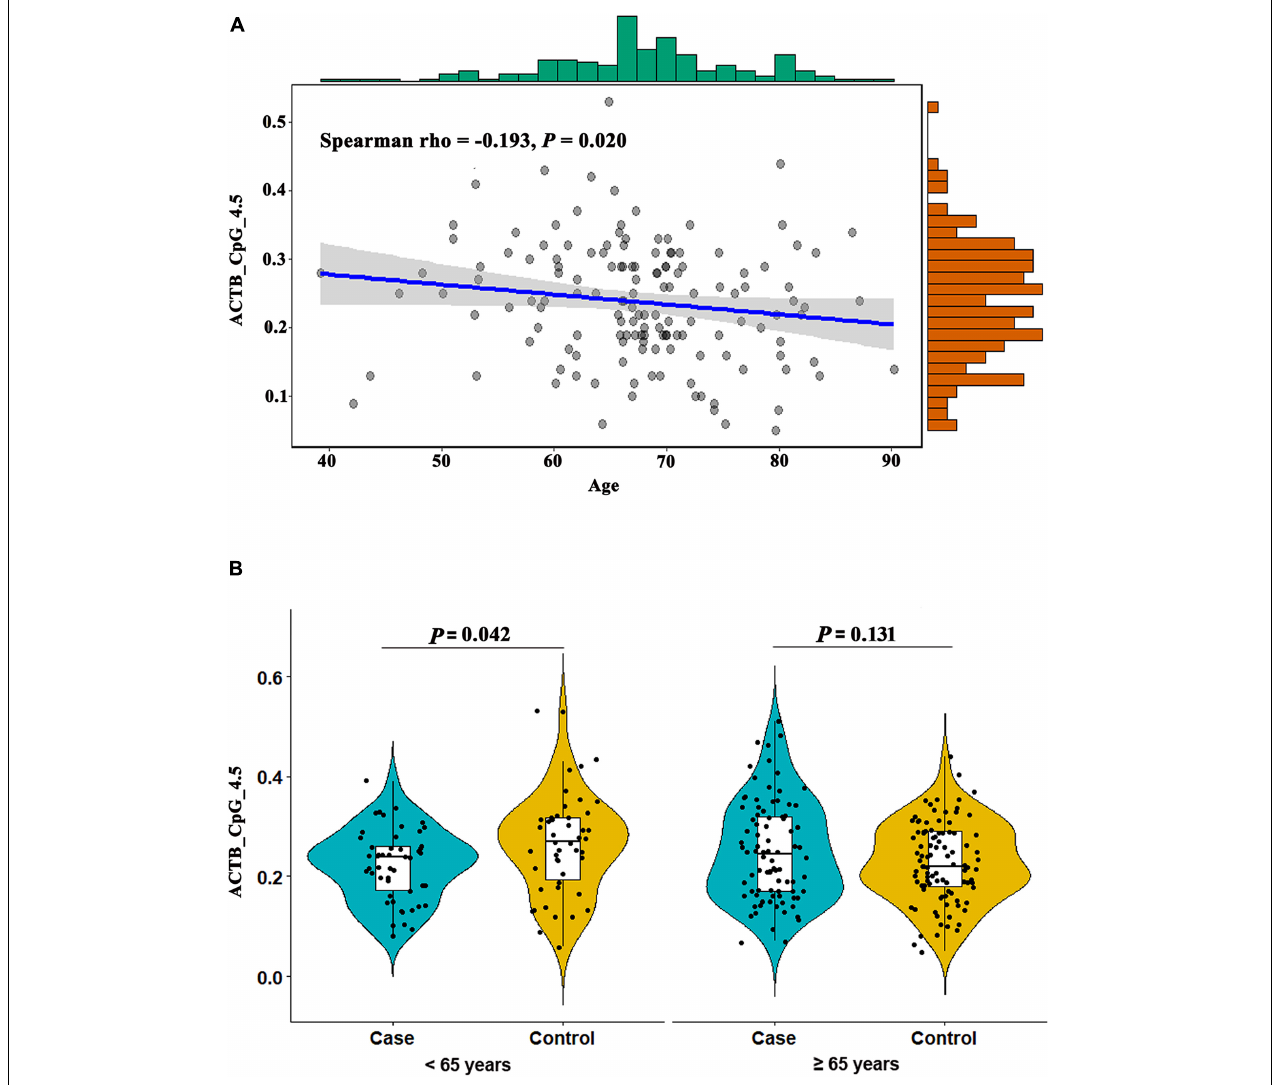
FIGURE 4 | Association between ACTB_CpG_4.5 methylation and age. (A) The inverse correlation between ACTB_CpG_4.5 methylation and age in controls. (B) Association between ACTB_CpG_4.5 methylation in peripheral blood and stroke stratified by age (65 years). The box plots show the distribution of ACTB_CpG_4.5 methylation levels in stroke cases and controls. The black dots represent the individual data of ACTB_CpG_4.5 methylation levels. The P -values were calculated by logistic regression adjusting for BMI, smoking, drinking, hypertension, diabetes, TC, TG, HDL-C, LDL-C, leukocyte counts and proportions of neutrophil, lymphocyte and